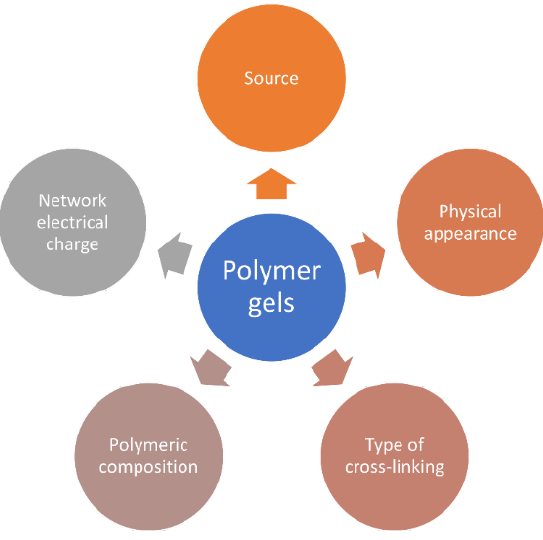
Figure 2. Classification of polymer gels.